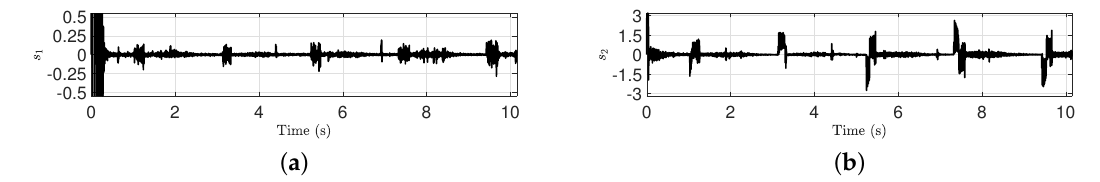
Figure 6. Sliding variables generated by the proposed SS-ASMC approach: ( a ) Joint 1. ( b ) Joint 2.